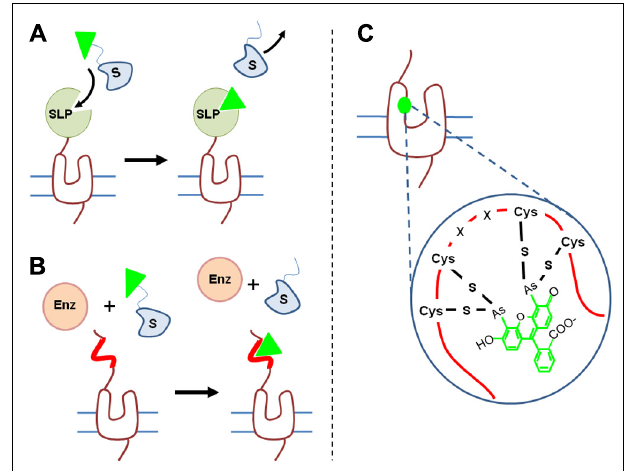
FIGURE 3 | Strategies to covalently label GPCRs. (A) SLP generally fused to the N-terminus of GPCRs catalyze the transfer of one fluorescent group (green triangle) from the substrate to itself.Various self-labeling proteins such as SNAP-tag, CLIP-tag, or HaloTag have been used to analyze receptor oligomerization. (B) Enzyme-based labeling: cells expressing tagged receptors are incubated in the presence of an enzyme such as AcpS and fluorescent substrate.The enzyme (Enz) catalyzes the transfer of one fluorescent group (green triangle) from the substrate to a specific tag incorporated into the receptor sequence (red line). (C) FlASH and ReASH strategies consists in introducing into the GPCR sequence a tetracysteine sequence (-C-C-X-X-C-C-) which reacts with fluorescent arsenical